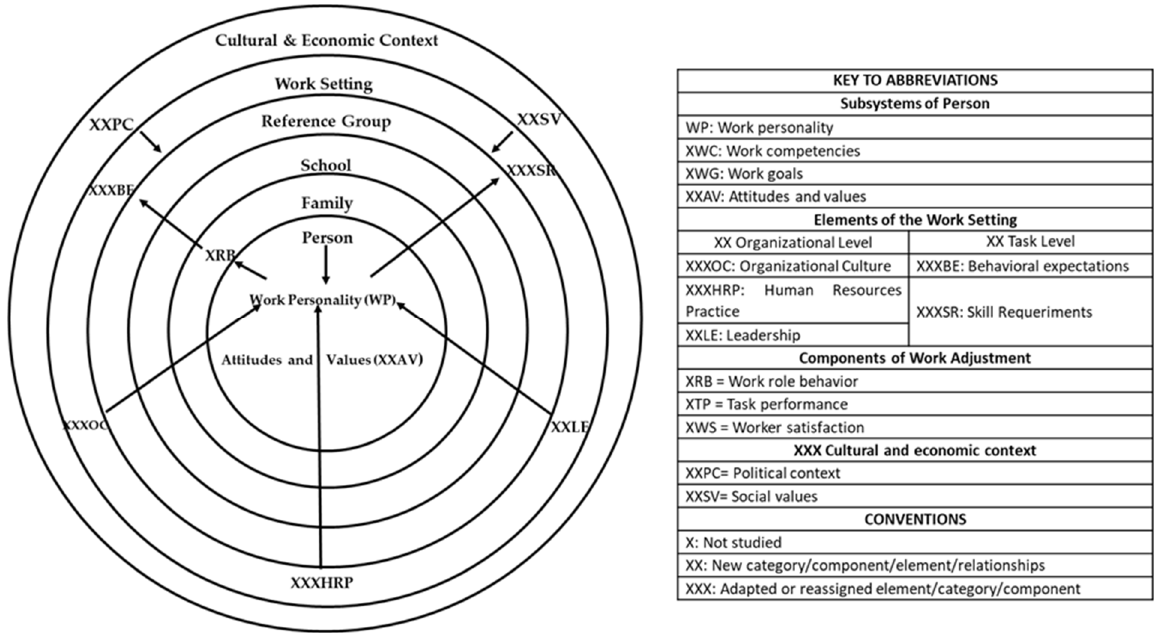
Figure 4 . Integrated findings. Source: authors. Figure 4. Integrated findings. Source: